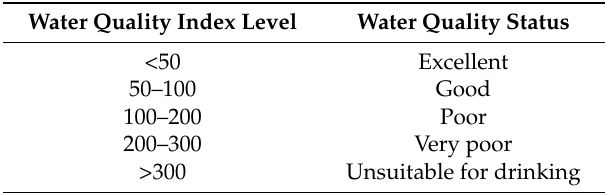
Table 4. Water quality index classification